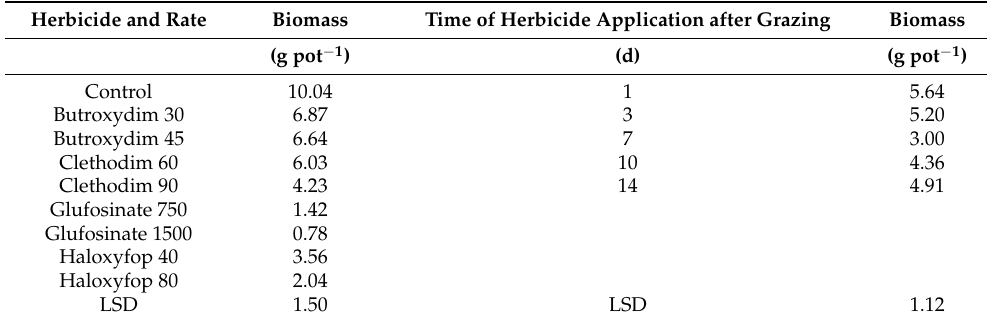
Table 3. The effect of herbicide treatment and their application timing (1, 3, 7, 10, and 14 d after grazing) on the aboveground biomass (g pot − 1 ) of Chloris virgata .